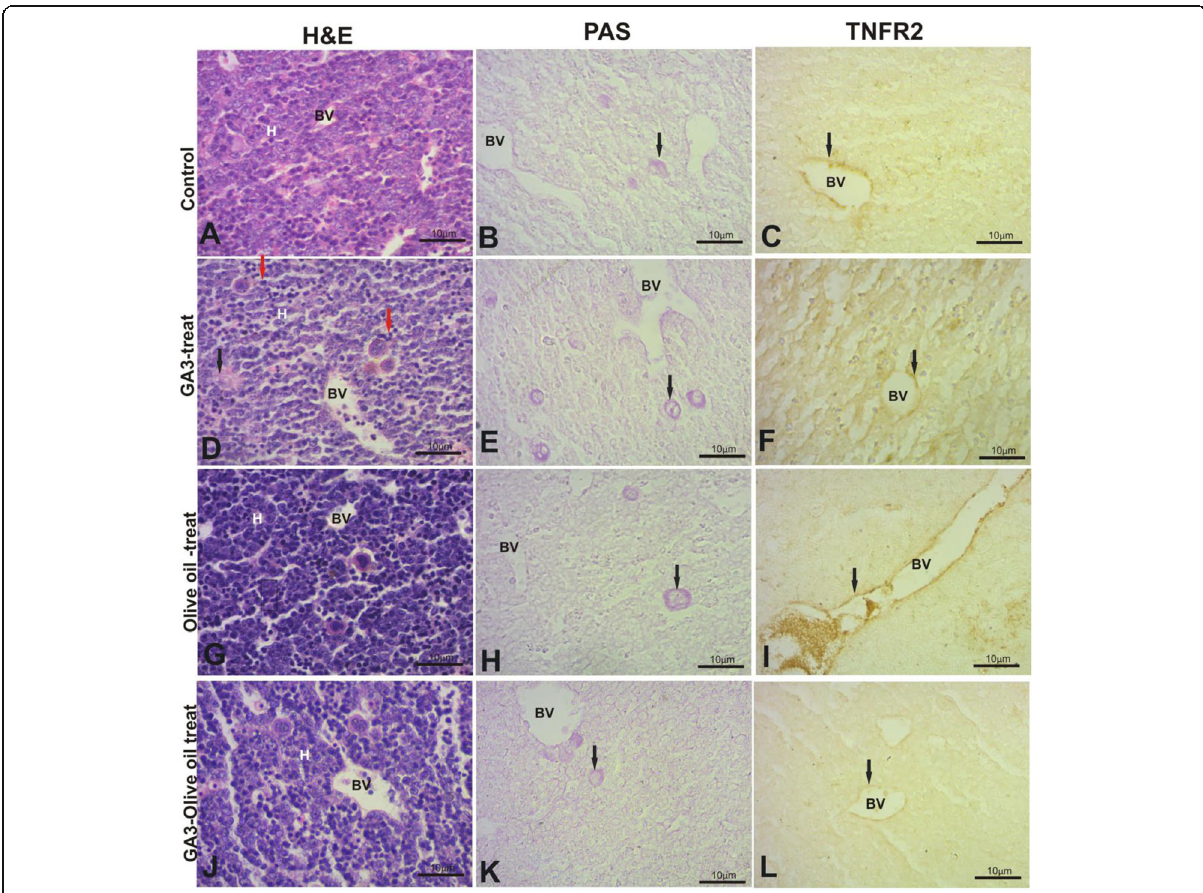
Fig. 4 Photomicrographs of H&E-, PAS-, and TNFR2-stained sections of developing liver at E14. The control liver showed normal structure of hematopoietic tissue, positive megakaryocytes in PAS reaction (black arrow, b ), and TNFR2 expression was localized in blood vessel (black arrow, c ). GA3-treated group exhibited loosely arranged hematopoietic cells (black arrow, d ), pyknotic cells (red arrow, d ), increase the number of megakaryocytes in PAS reaction (arrow, e ), and decrease TNFR2 expression (arrow, f ). Olive oil-treated embryo did not exhibit any histopathological alteration ( g , arrow h , arrow i ). GA3-olive oil- treated embryo showed improvement in the GA3 alterations ( j , arrow k , arrow l ). BV, blood vessel; H, hematopoietic. Scale bar ( a – l ) = 10 μ